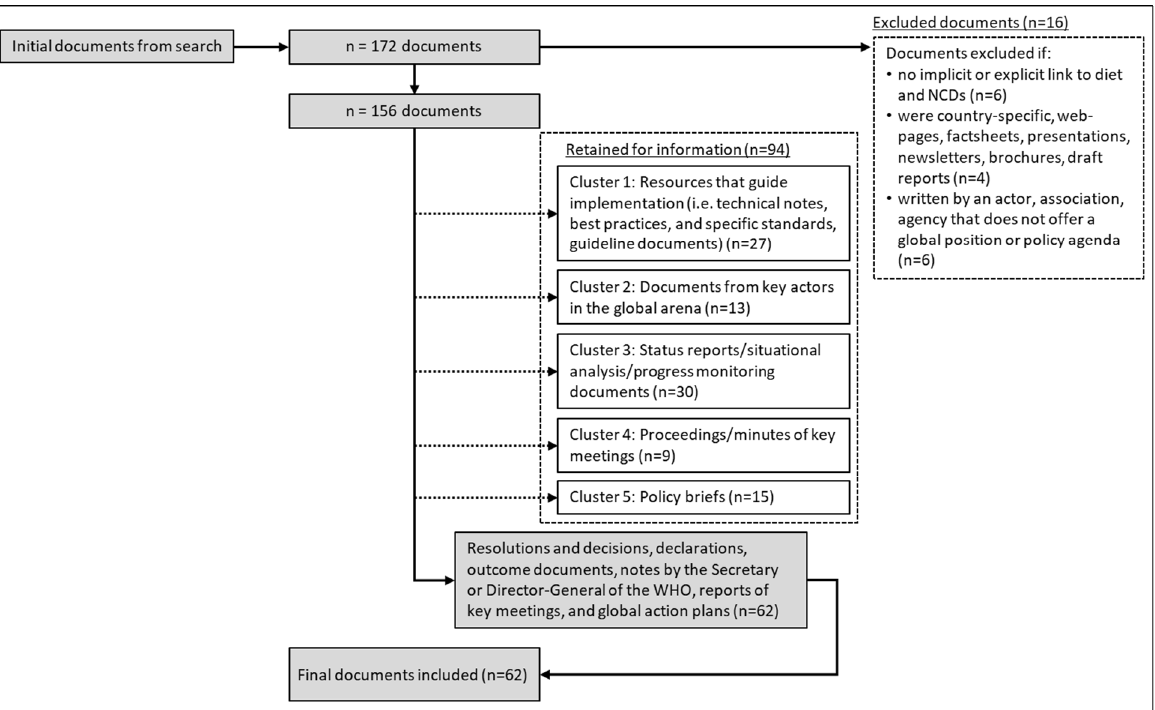
Figure 1. Flow diagram of data cleaning and document clustering process for the global policy analysis.